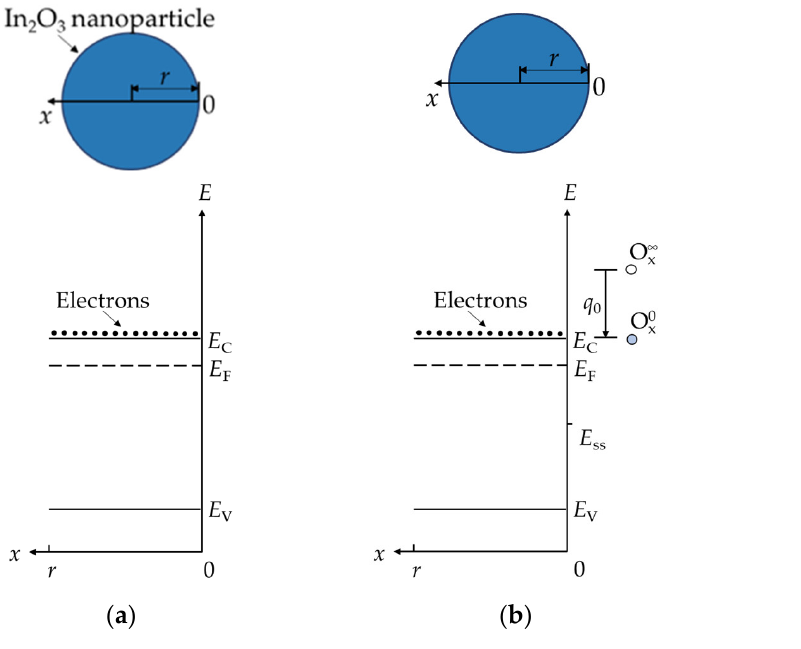
Figure 5. Schematic diagram of the energy band distributions and the electron distributions of In 2 O 3 particles based on the Wolkenstein adsorption theory (Note that Pt was not indicated in this figure). ( a ) An ideal pure In 2 O 3 particle. ( b ) The particle under weak chemisorption of oxygen. ( c ) The particle with strong chemisorbed oxygen (O − x ) after thermal equilibrium and electron depletion near the surface. ( d ) The particle undergoing a reduction reaction after the presence of hydrogen. E C , E F , and E V represent the conduction band, Fermi energy level, and valence band, respectively. The superscripts s and b represent the parameters of the surface and the core of an In 2 O 3 particle, respectively. The binding energy of weak chemisorption is denoted as q 0 . O x∞ , O x0 , and O x are the oxygen species before adsorption, weakly adsorbed, and strongly adsorbed, respectively. ∆ H represents the difference between the adsorption energy of oxygen species and the chemical energy of the reaction between the sensitive material and H 2 , r is the average radius of indium oxide particles, and x d0 and x d are the thickness of the depletion layer at oxygen adsorption equilibrium and after the reaction with hydrogen, respectively.